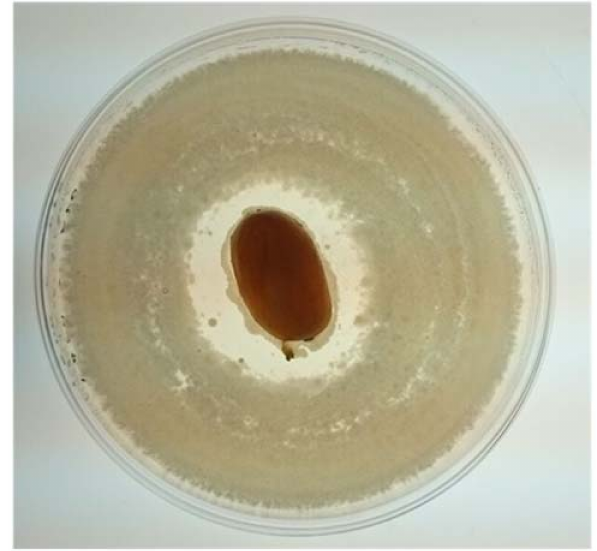
Figure 3. Antagonistic activity on fruits. The grape was soaked with a suspension of P. methanolica H1/3-1 and placed on PDA inoculated with spores of B. cinerea 887. Around the treated grape, a clear zone of fungal growth inhibition is